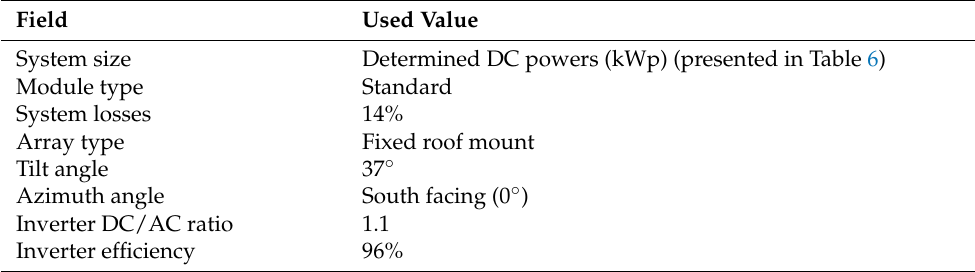
Table 5. Input parameters of the PVWatts module in EnergyPlus